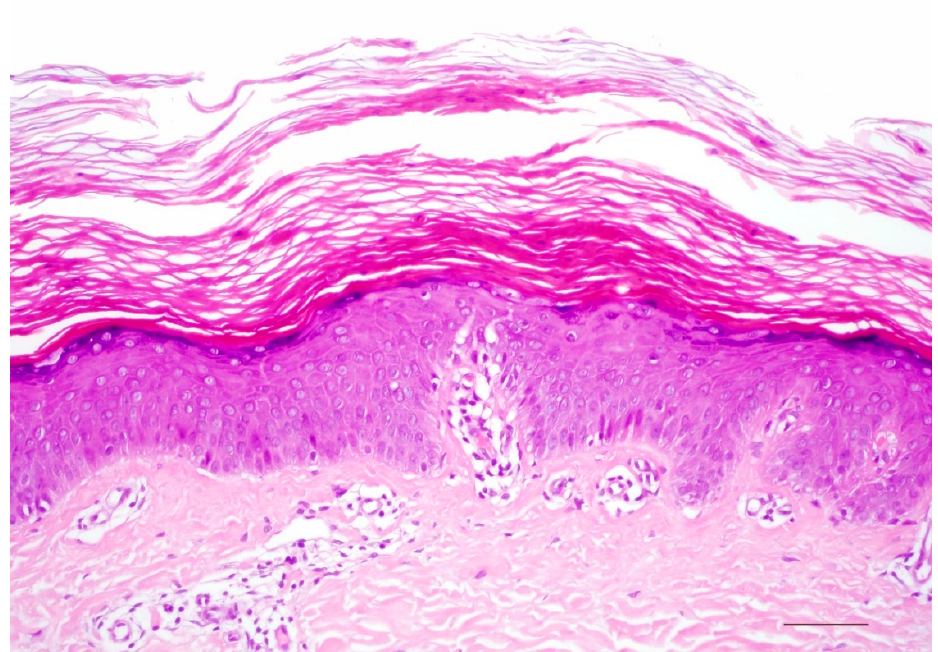
Figure 7. Erythrokeratoderma. Acanthotic epidermis with orthohyperkeratosis, focal parakerato- sis, dyskeratotic keratinocytes, and preserved stratum granulosum. Discrete superficial perivascular lymphocytic infiltrate. HE stain, bar = 100 µm.